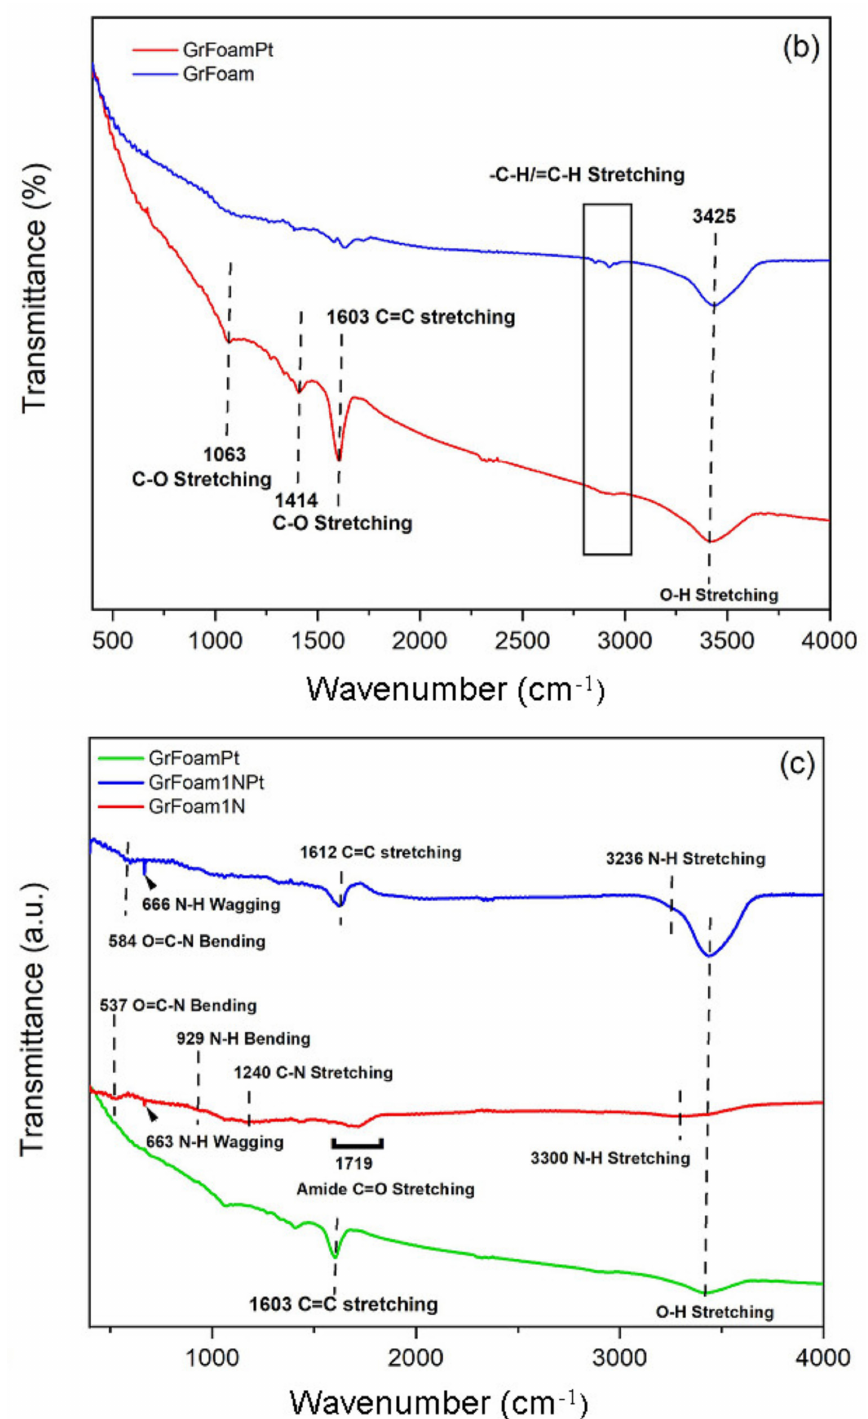
Figure 5. The overlaid FTIR spectra of: ( a ) GrFoam1N, GrFoam2N, and GrFoam3N; ( b ) GrFoamPt; ( c ) GrFoam1N and GrFoam1NPt, in comparison with pristine